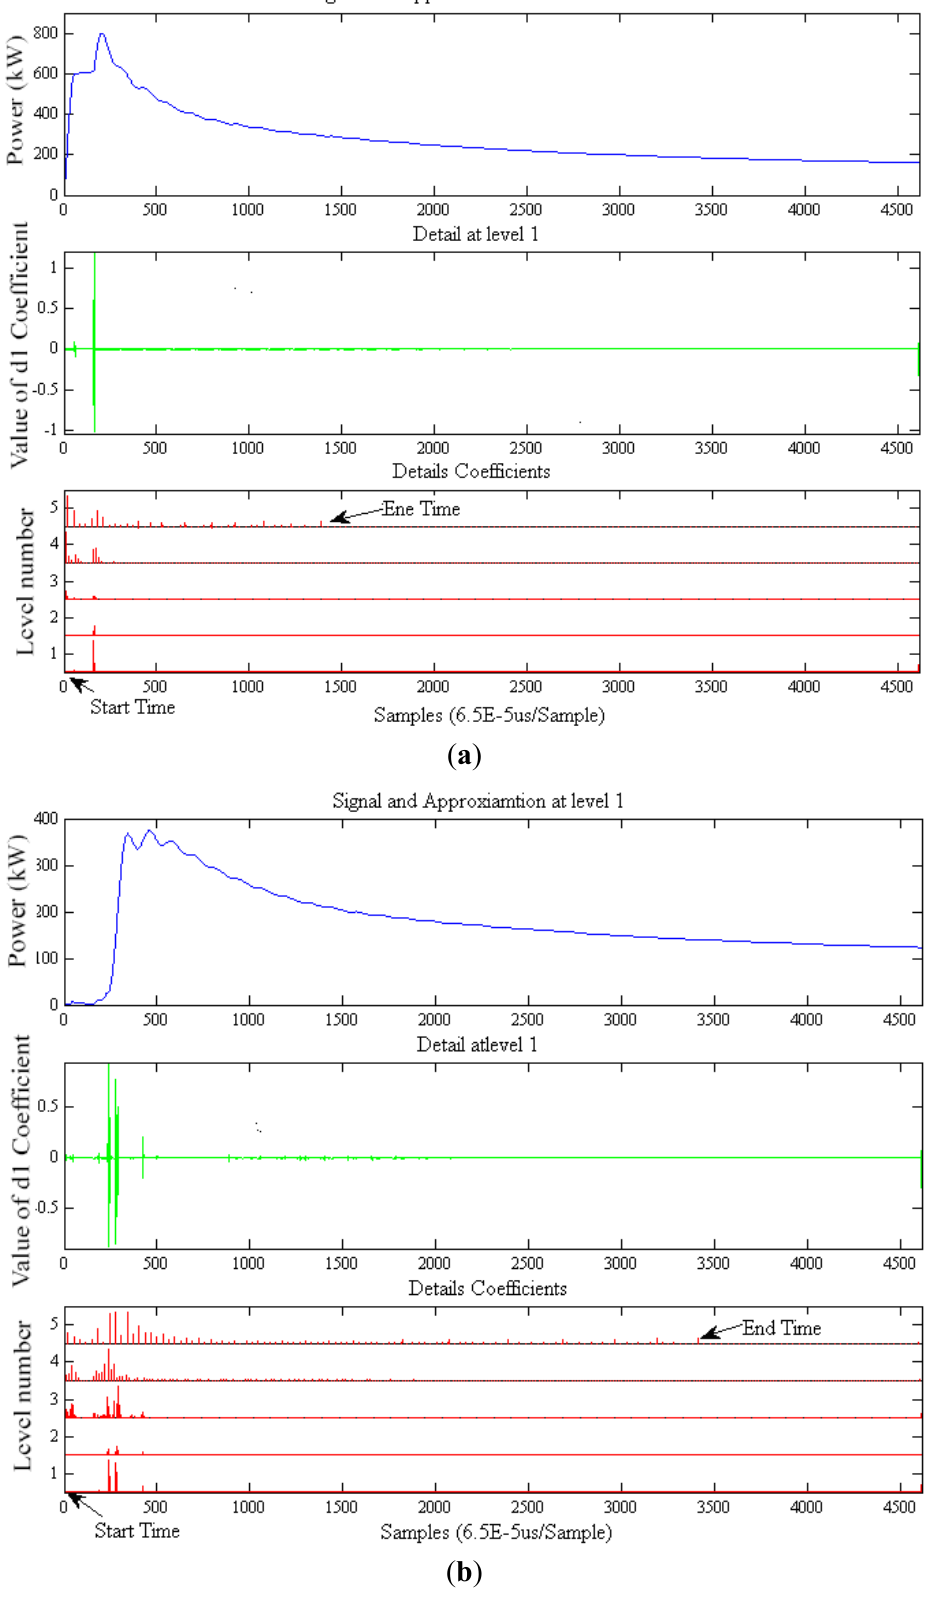
Figure 7. The DWT results of turn-on instantaneous power transients. ( a ) a 160 hp induction motor; ( b ) a 123 hp induction motor driven by variable-voltage drives; ( c ) a bank of loads supplied by a six-pulse thyristor rectifier for AC